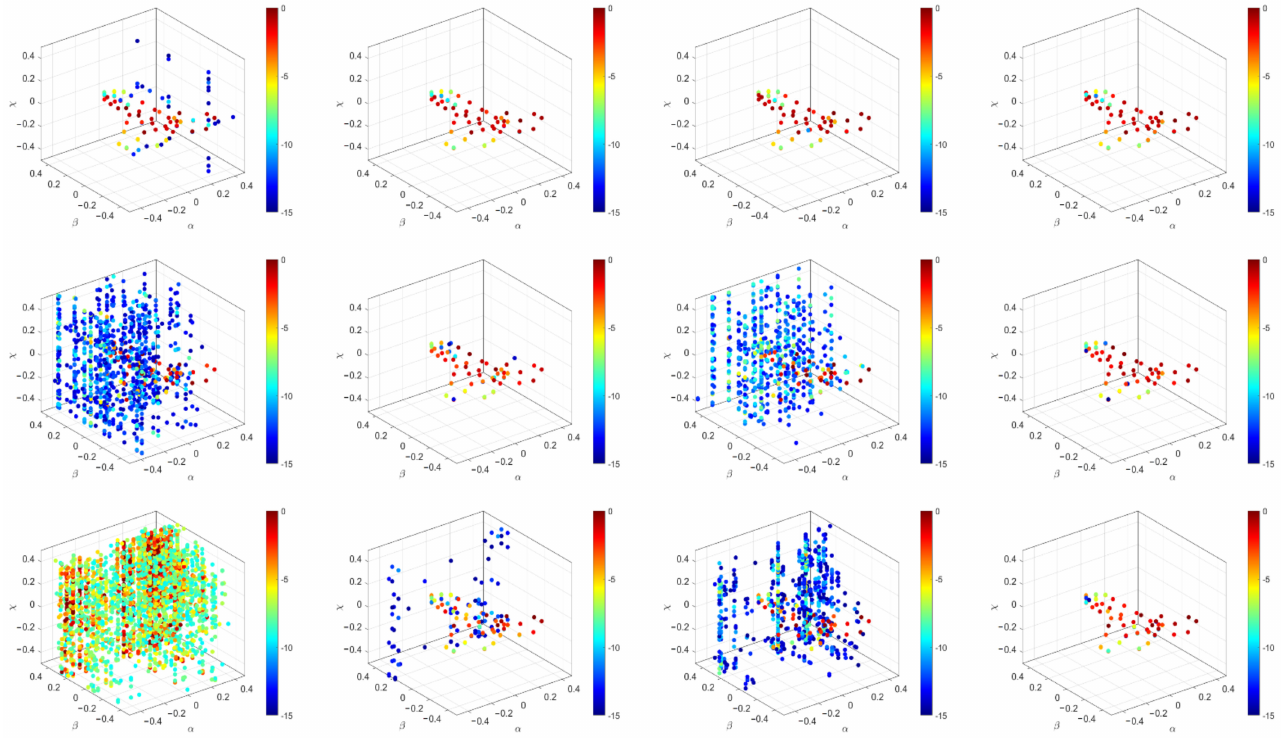
Figure 11. The imaging results obtained by different imaging methods under different